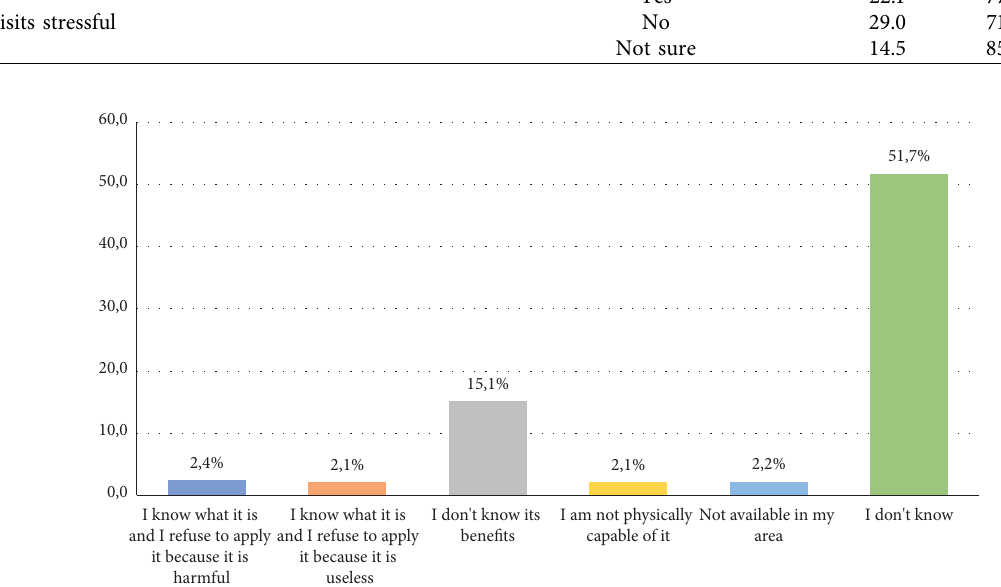
Figure 3: Reasons of refusing fuoride varnish application as reported by